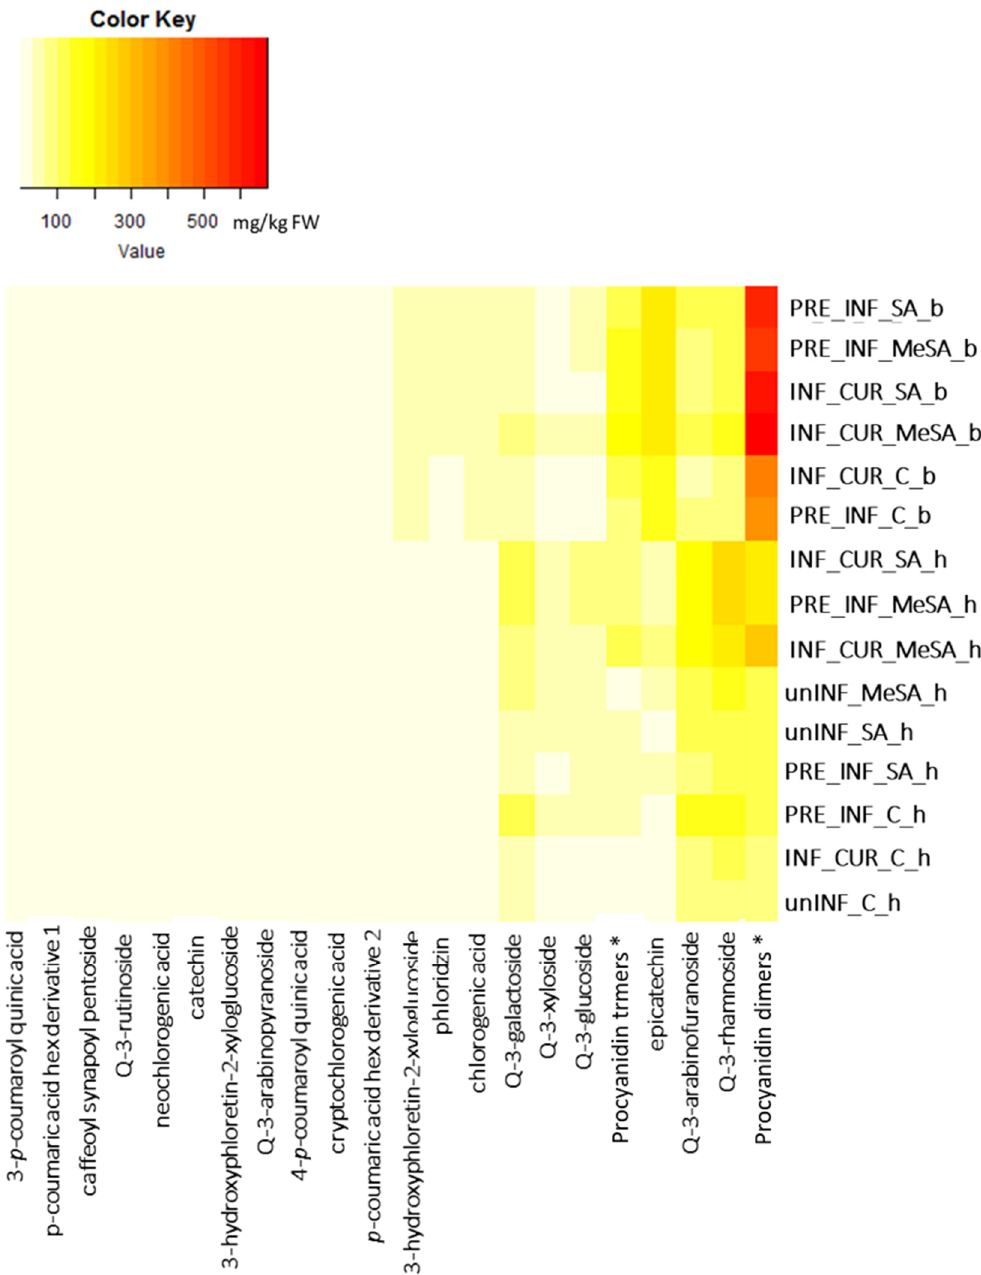
Figure 3. Heatmap for the content of all analyzed individual phenolic compounds (mg/kg FW) in uninfected (unINF) and infected (INF) healthy (h) and boundary (b) tissue of apple peel around the lesion caused by the fungus M. laxa , treated preventively (PRE) and curatively (CUR) with salicylic acid (SA) and methyl salicylic acid (MeSA). C: control, Q: quercetin, *: sum of all derivatives. Yellow, lower content of individual phenolics; red, higher content of individual phenolics.